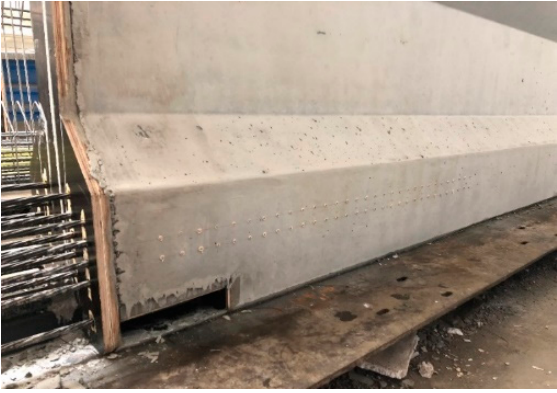
Figure 8. DEMEC points attached to the test girder.